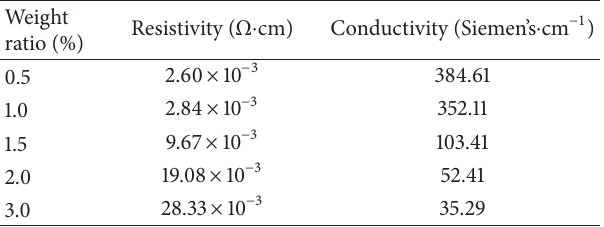
Table 1: Resistivity and conductivity of TiO 2 thin films with varying wt% of carbon